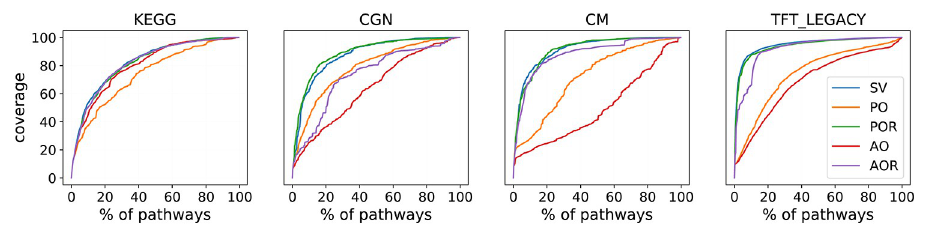
Fig 3. Cumulative coverage of gene sets. In the plots: the coverage of the genes as a function of the number of pathways included using the different rankings. In the Table: coverage of the genes when selecting respectively the 10, 20 and 40% of the pathways. In each column, underlined text highlights the highest